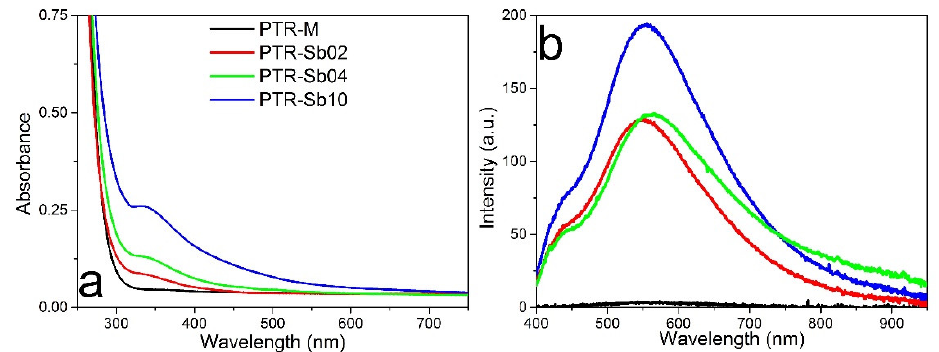
Figure 14. Absorbance ( a ) and emission ( b ) spectra of undoped PTR-M and antimony-doped PTR glass samples ion-exchanged for 15 min and heat-treated at 450 ◦ C for 15 h. The excitation wavelength glass samples ion-exchanged for 15 min and heat-treated at 450 °C for 15 h. The excitation wave- was 350 nm. length was 350 nm.